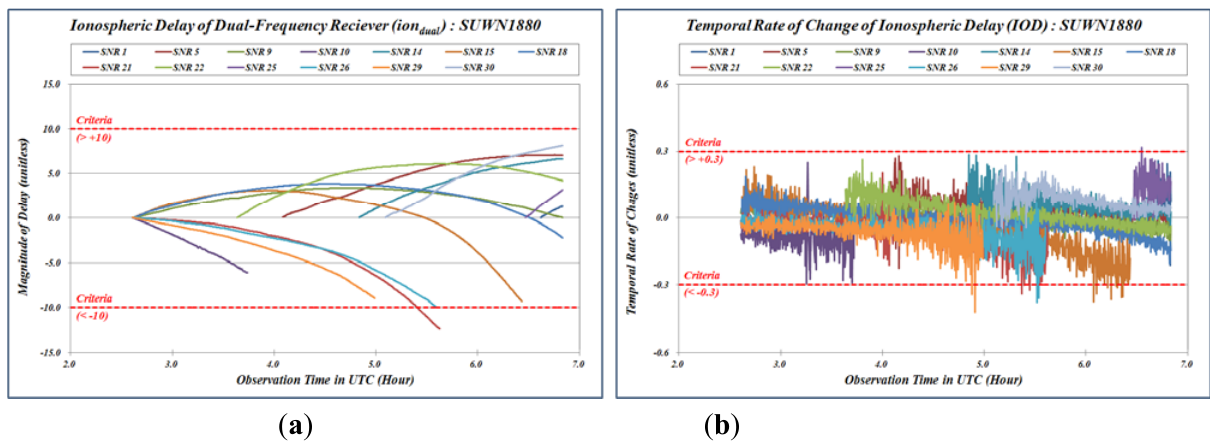
Figure 6. Quality control indicators related to ionospheric effects. ( a ) Time-series plots of ion at each observation epoch. ( b ) Time-series plots of iod at each observation epoch.